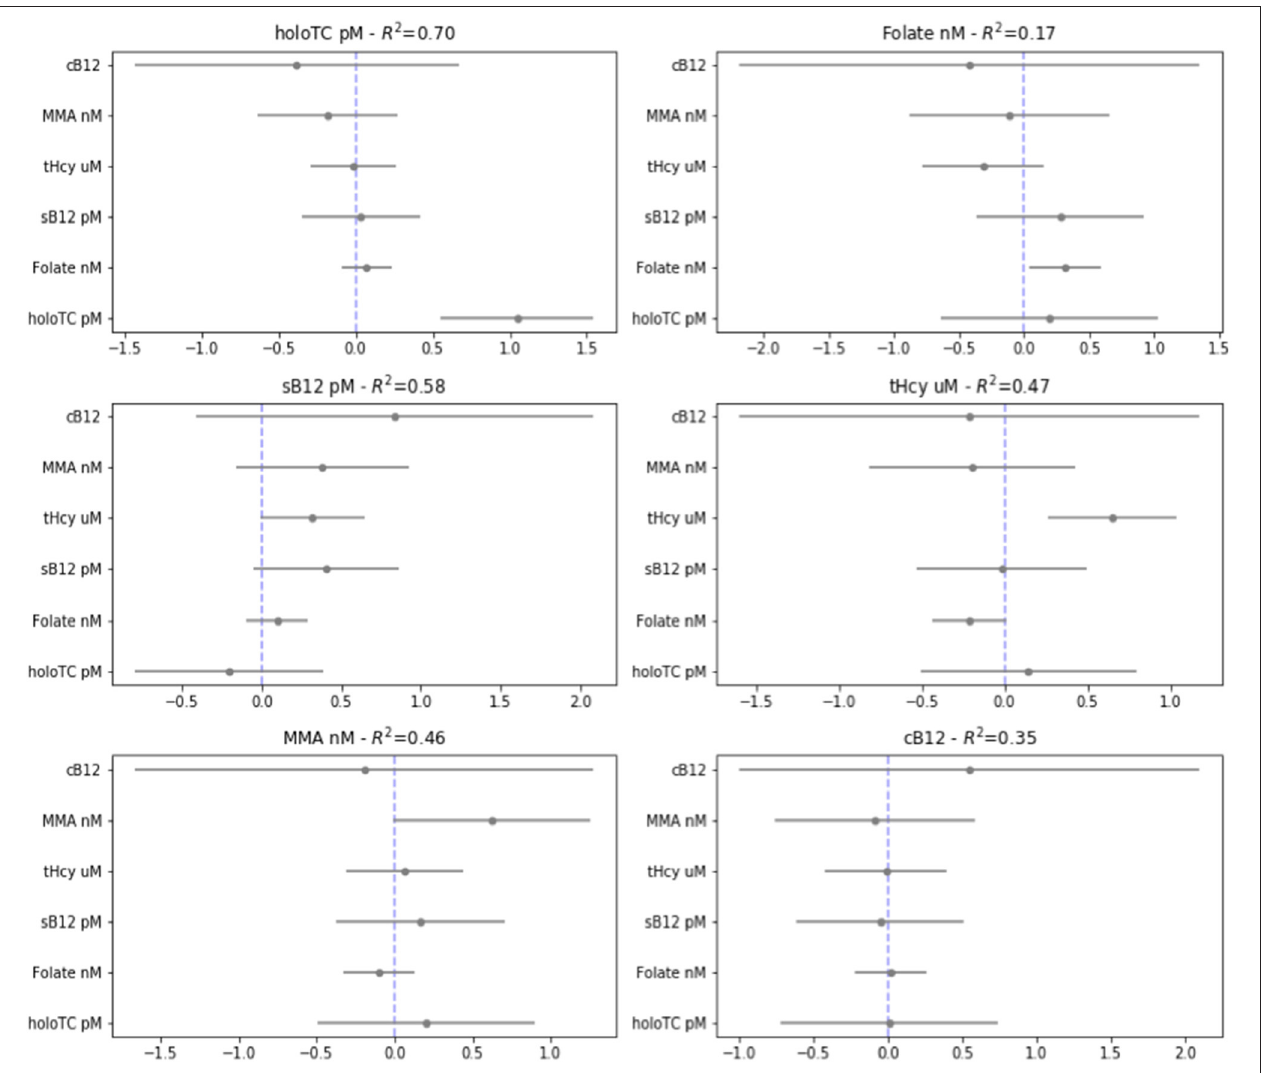
FIGURE 5 | Regression analysis from the third to the first trimester. Visualization of multiple linear regression analysis, showing coefficient and standard errors, examining whether each biomarker [transcobalamin (Holo TC, pmol/L), serum folate (Folate, nmol/L), serum B 12 (pmol/L), homocysteine (tHCy, micromol/L), methylmalonic acid (MMA, nmol/L), plus score of combined B12 (cB 12 )] in the third trimester of normal pregnancy [T3] can be significantly predicted by the same or the other baseline biomarkers measured in first trimester of pregnancy [T1] (given on the y-axis). This was calculated using a standardized outcome variables for linear regression, with 95% confidence intervals on the